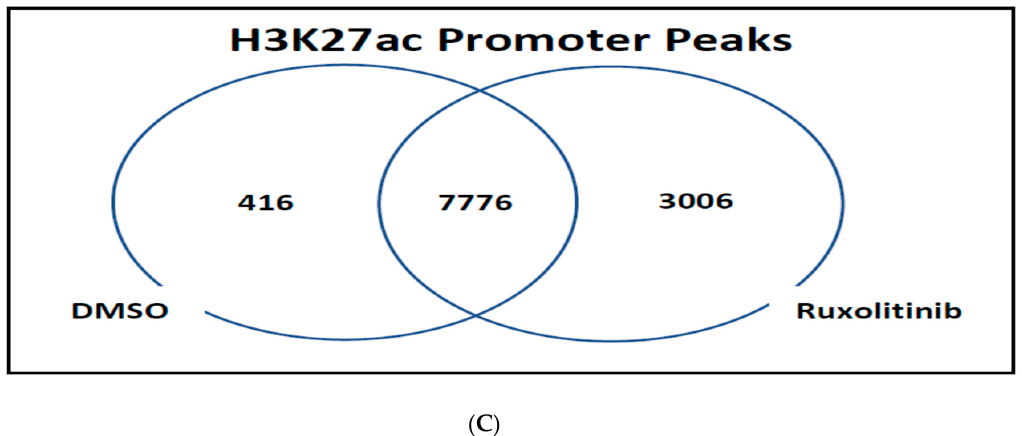
Figure 2. ( A ) Western blots for monomethylation levels at lysine 36 on histone H3 in MPN cell lines (UKE-1, SET-2 and HEL) treated with vehicle control or 100 nM ruxolitinib for 2, 4, 8 or 24 h (once or twice daily). Densitometry values are normalised for loading control. ( B ) A heat plot comparing global gene expression from RNA seq analysis for ruxolitinib and DMSO treated HEL cells. ( C ) A Venn diagram demonstrating the number of exclusive H3K27ac peaks at gene promotor regions in cells treated with ruxolitinib or DMSO control. The middle represents the common peaks between the two treatments.